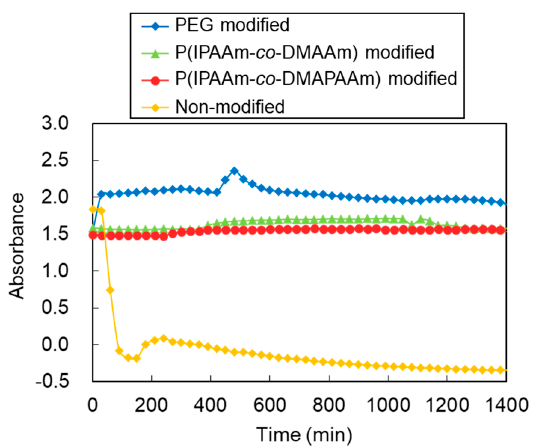
Figure 3. Stability of liposomes in serum for 24 h at 37 °C. Monitoring wavelength: 450 nm. Serum concentration: 50 v / v %.